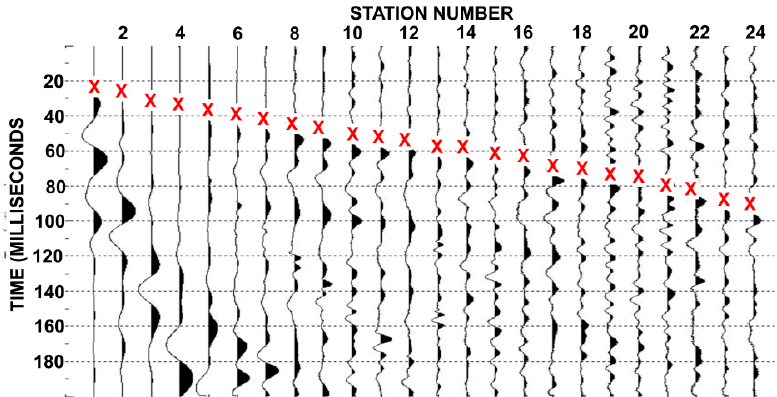
Figure 7. “Shot gather” screen shot from Rayfract 3.14. First break picking: Red X: Software picks used to create lowest RMS error from wave crossover distances after 20 WET iterations.